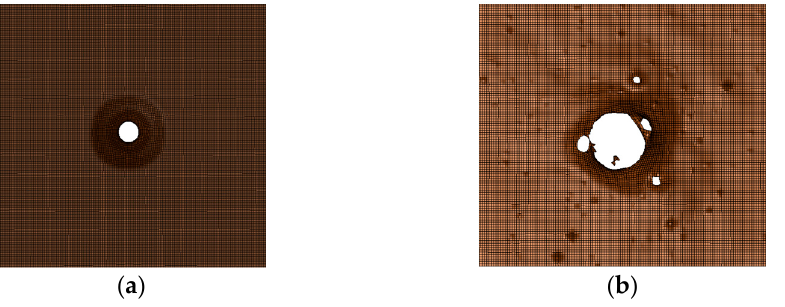
Figure 7. Impacted second layer of the target plate: ( a ) caused by the inert inner core PELE projectile and ( b ) caused by the active inner core PELE projectile.